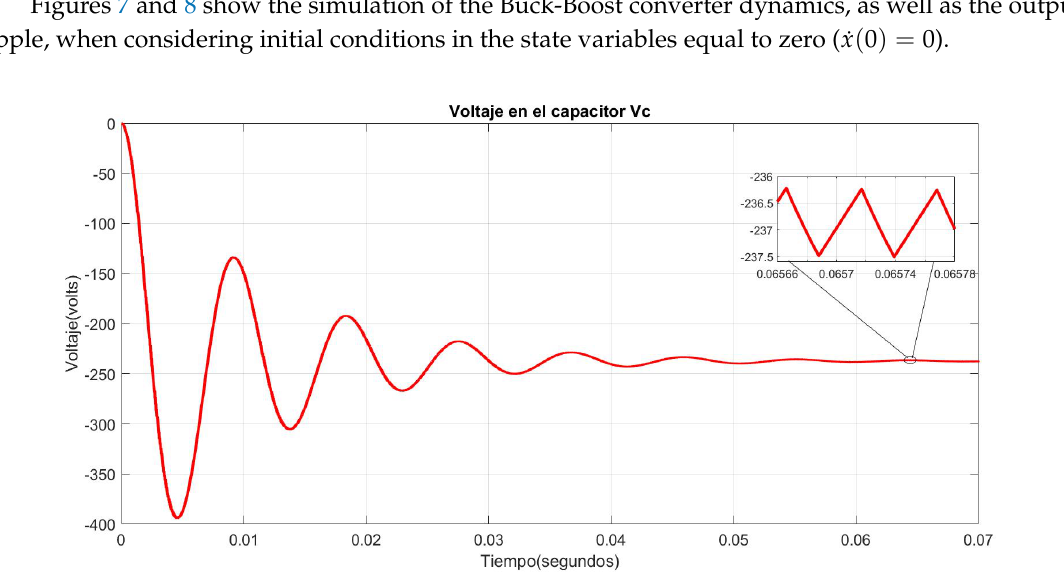
Figure 7. Capacitor voltage in the Buck-Boost switching